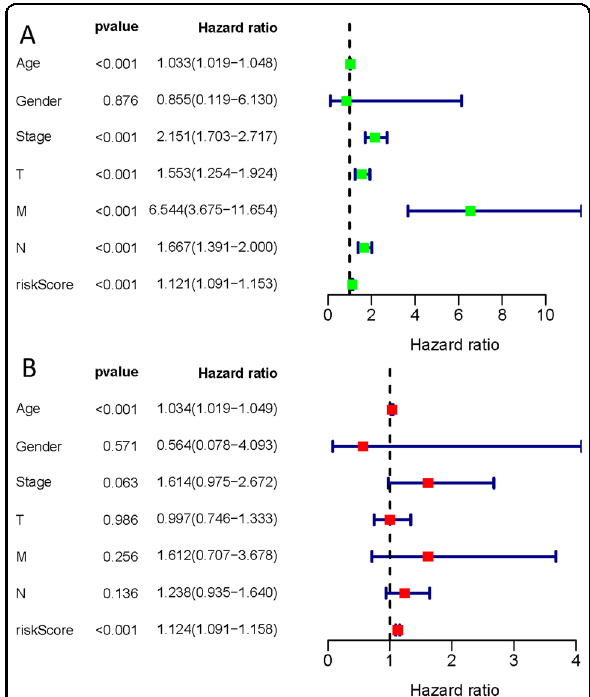
Fig. 3 Univariate and multivariate cox proportional hazards model (Hazard Ratio, HR) to identify independent prognostic factors. A Univariate cox regression analysis identify of individual factors related to patient survival; B Multivariate cox regression analysis identify independent prognostic factors and the result indicated that our signature could as independent prognostic factors for overall survival (HR: 1.124; 95% CI: 1.091 – 1.158). Green means the value of hazard ratio